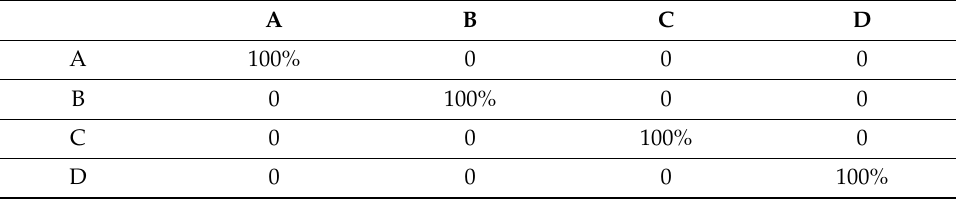
Table 5. Confusion matrix achieved for the Common variety accessions of set 1: A, Pera Ipigua, B, Ovale, C, Pera Mahle and D, Pera Ol í